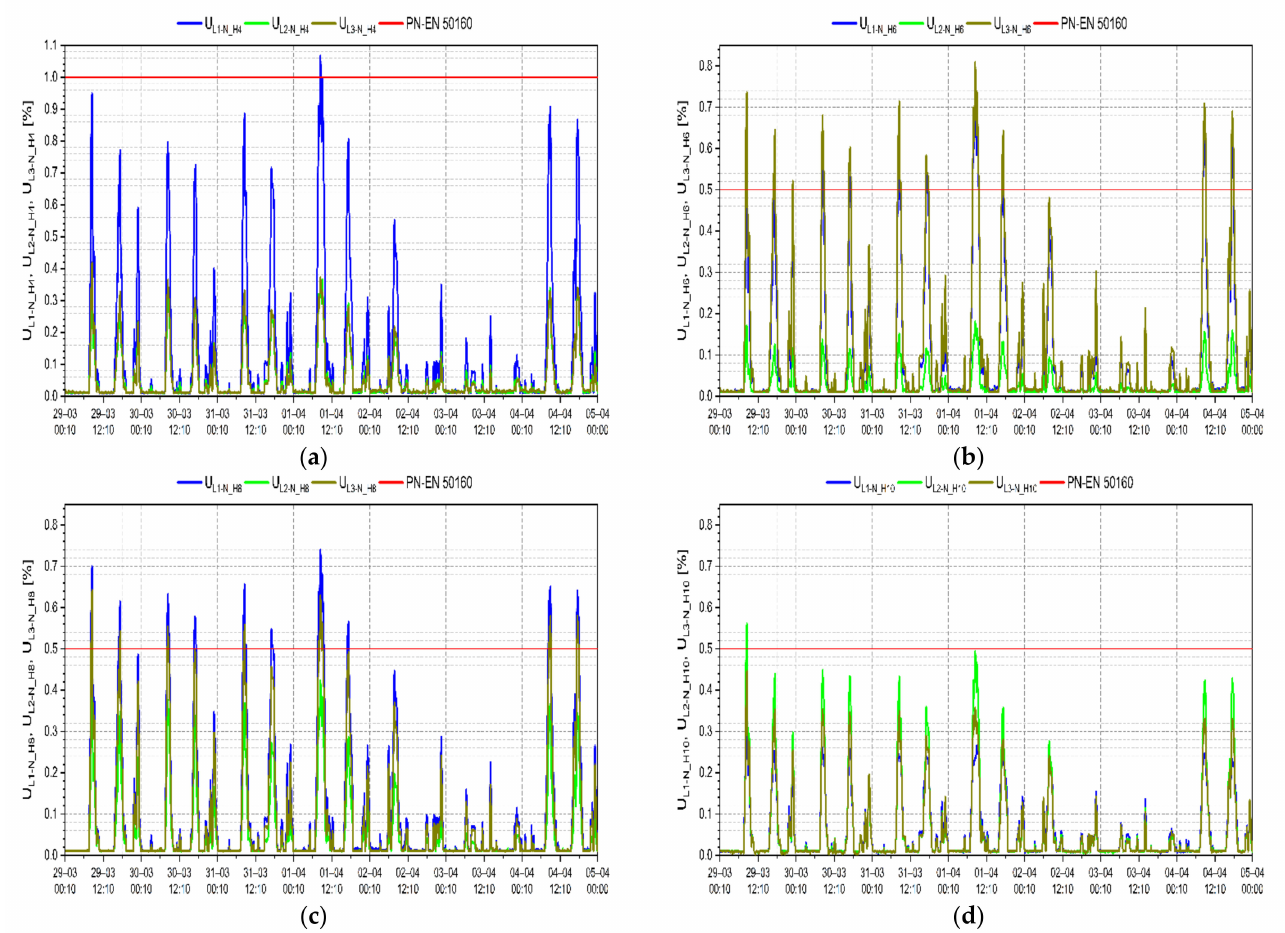
Figure 12. The individual voltage harmonic variation (10 min averaged): ( a ) 4th harmonic; ( b ) 6th harmonic; ( c ) 8th harmonic; ( d ) 10th harmonic during the measurement